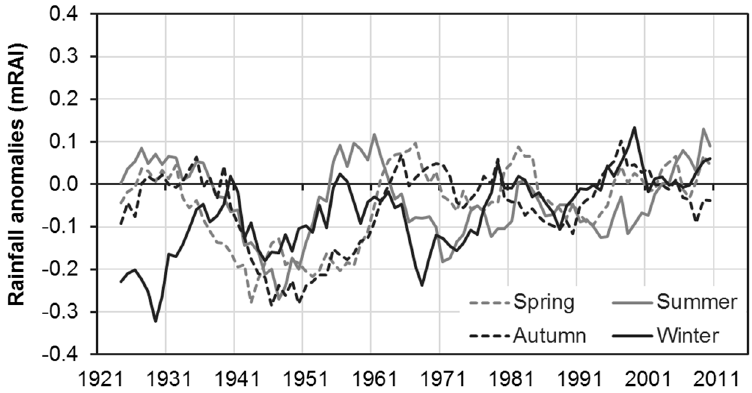
Figure 5. Time series (11-year moving averages) of the seasonal European precipitation anomalies (mRAI-3 for May, August, November, and February; station average) for period 1921–2015.